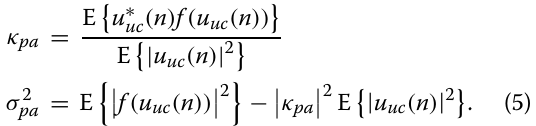
residual baseband SI channel already takes into account these cancellation